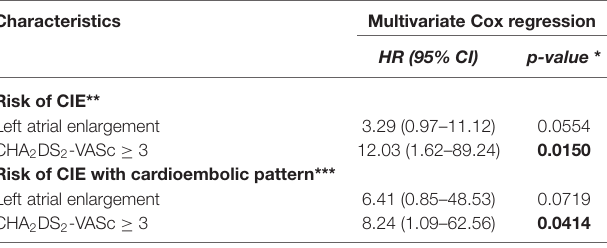
TABLE 4 | Cox regression analysis of survival free from Cerebral Ischemic Events (CIE) in 114 patients with Transthyretin Cardiac Amyloidosis (multivariate analysis).